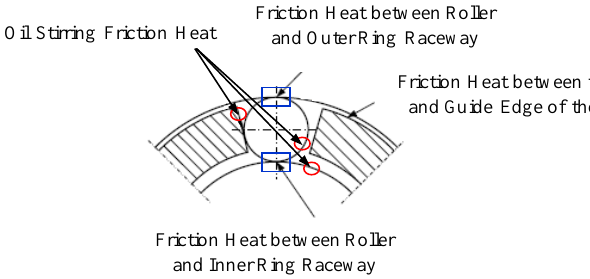
Figure 2. Friction power loss analysis model.